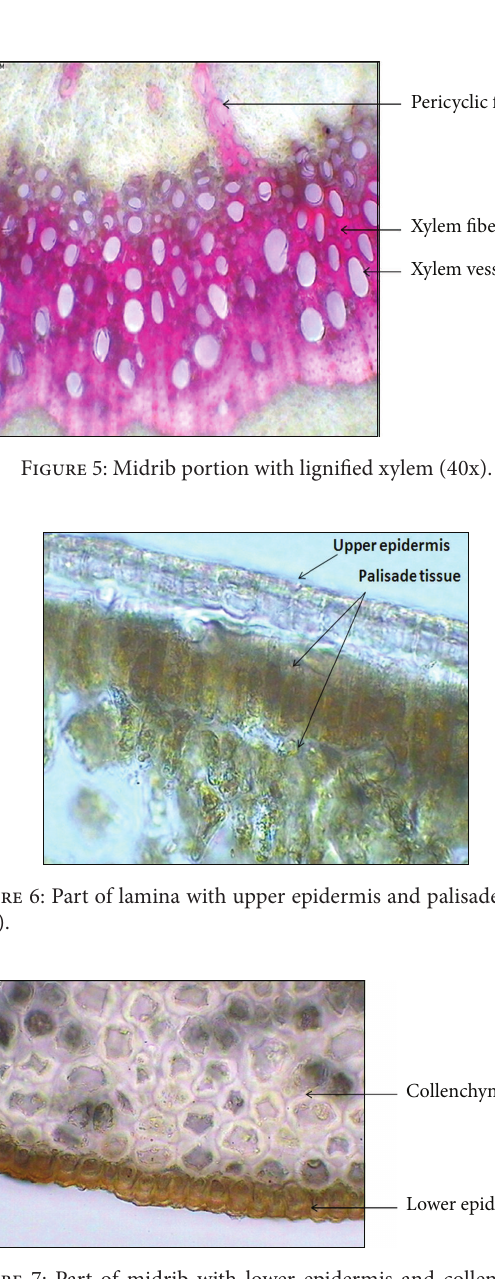
Figure 7: Part of midrib with lower epidermis and collenchyma (40x).